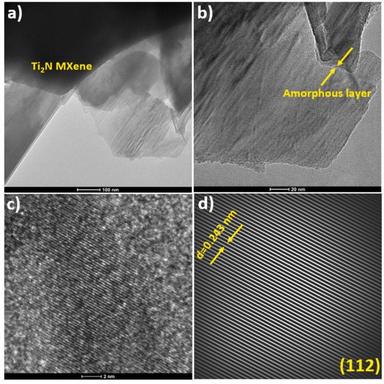
HRTEM image of Ti2NTx MXene a) low magnification of MXene, b) and c) high magnification of MXene, and d) interplanar d-space of MXene.